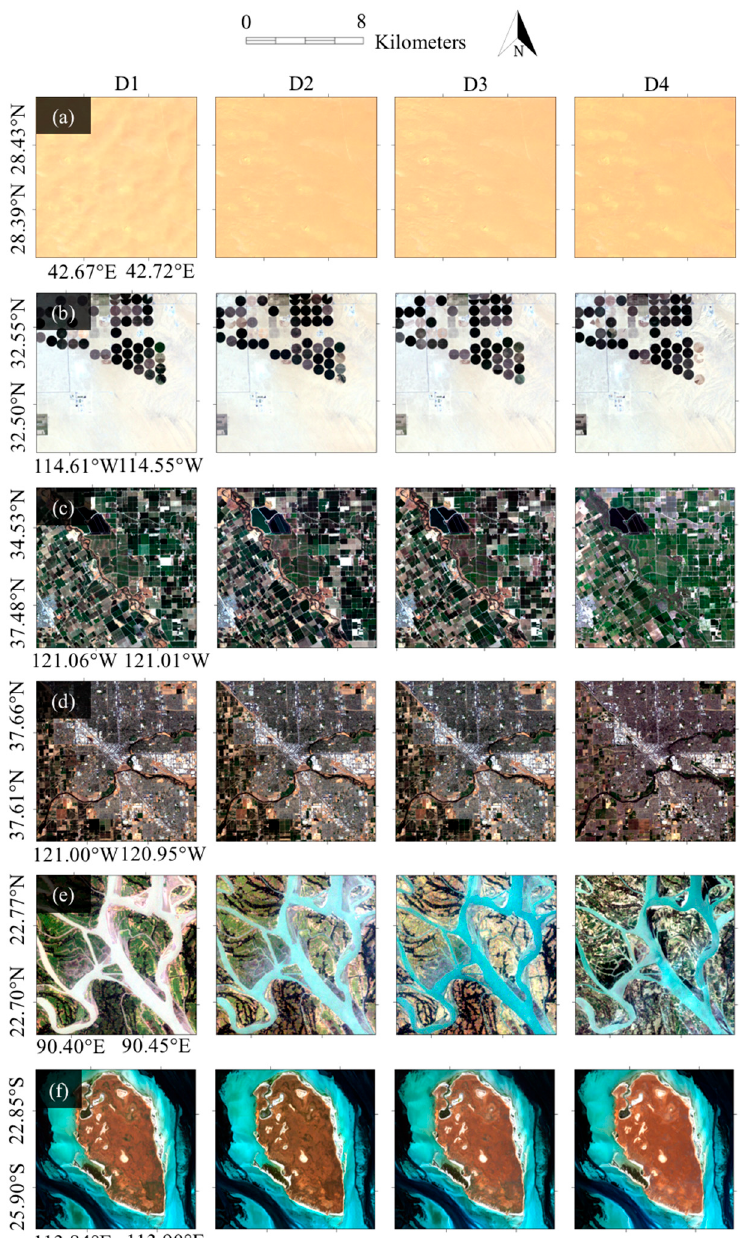
Figure 5. ETM+ images for the six studied regions and the different temporal images used in analysis (see Table 1), corresponding to ( a ) desert; ( b ) sparse agricultural; ( c ) dense farmland; ( d ) urban; ( e ) braided river and ( f ) coastal area.